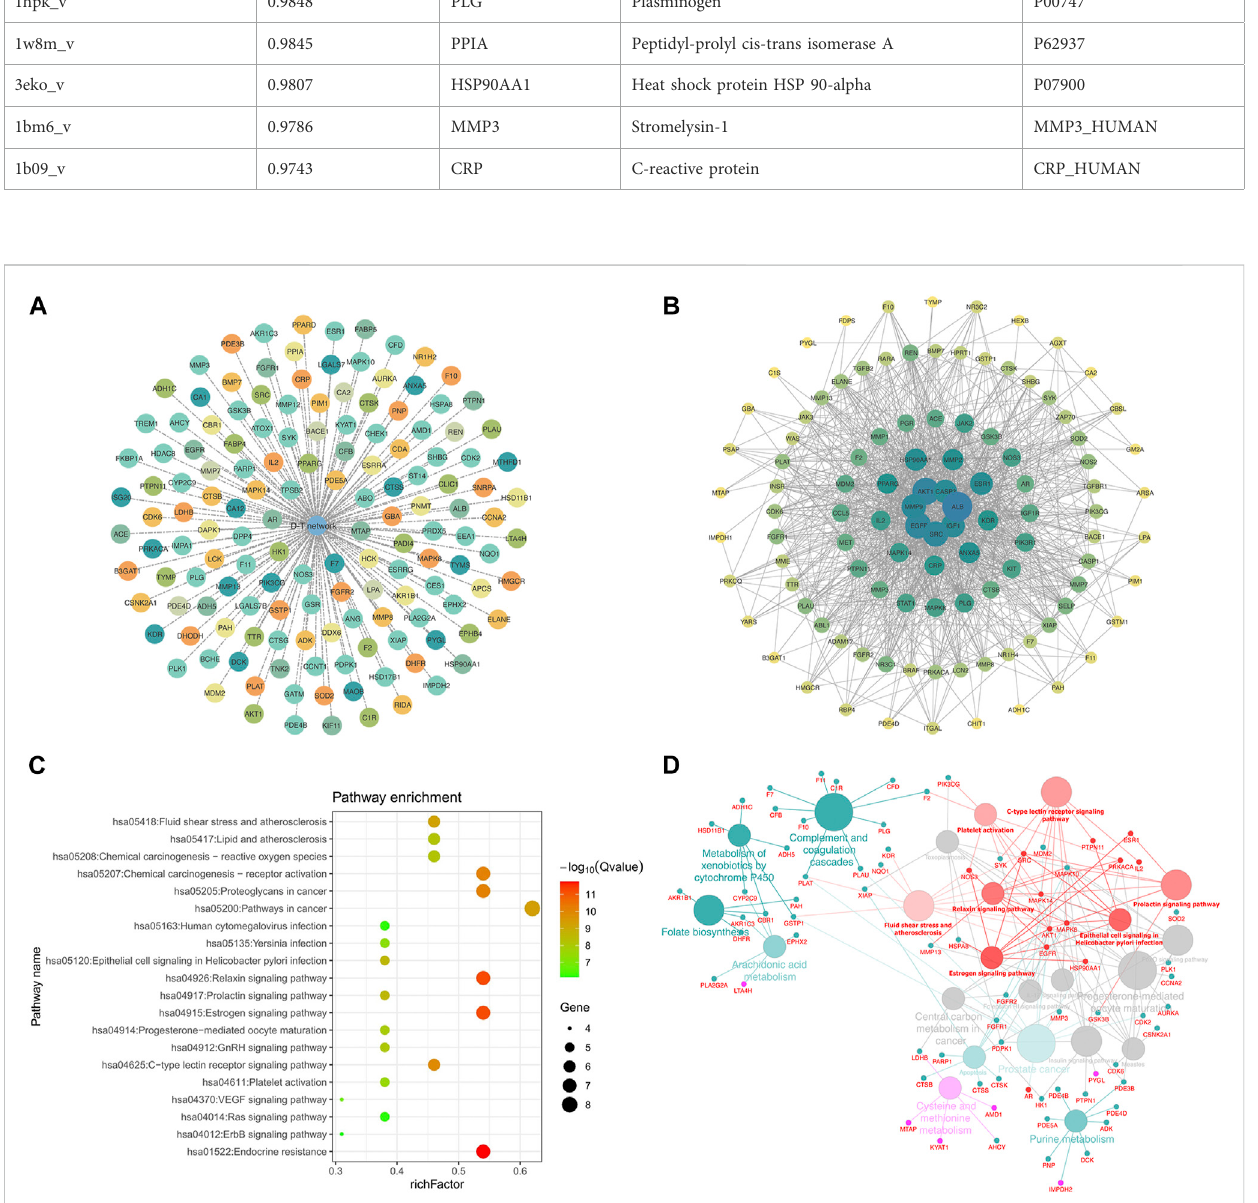
FIGURE 4 Networkpharmacologytargetingandpathwayenrichment. (A) T-Tnetworkofcommontargets. (B) PPIinteractionnetworkofcommontargets. (C) KEGG pathway enrichment analysis. (D) Enrichment results of Hub gene pathways analyzed by ClueGO. Red indicates the enrichment results of the common